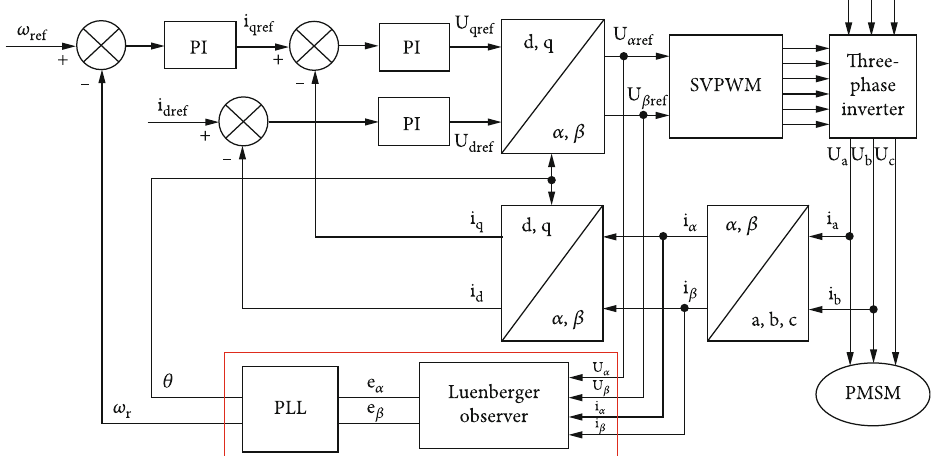
Figure 5: Block diagram of PMSM sensorless control system based on 2021 LO.